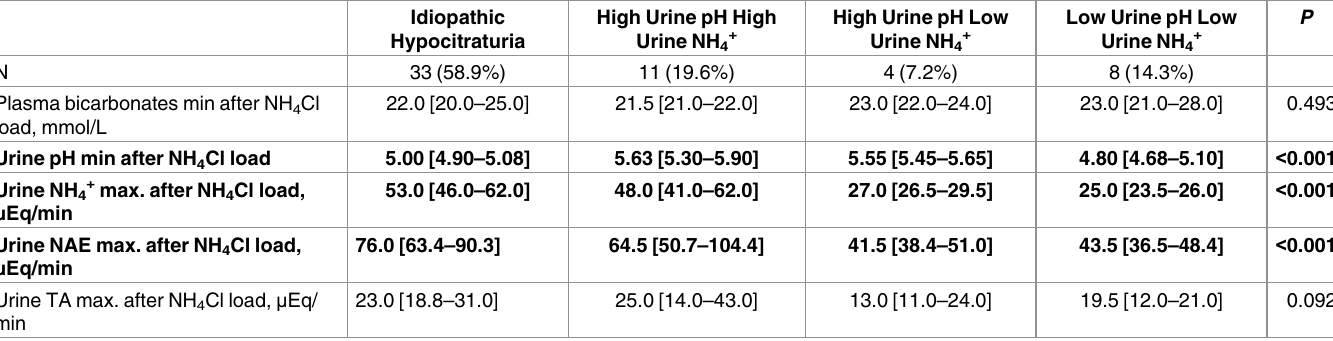
Table 4. Biological results after the acute acid load test of the 56 patients with normal baseline plasma HCO 3- . Idiopathic